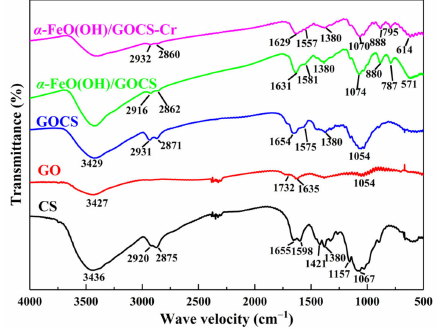
Figure 2. FT-IR spectra of GO, CS, GOCS, α –FeO(OH)/GOCS before Cr(VI) adsorption, and that of α –FeO(OH)/GOCS after adsorption for